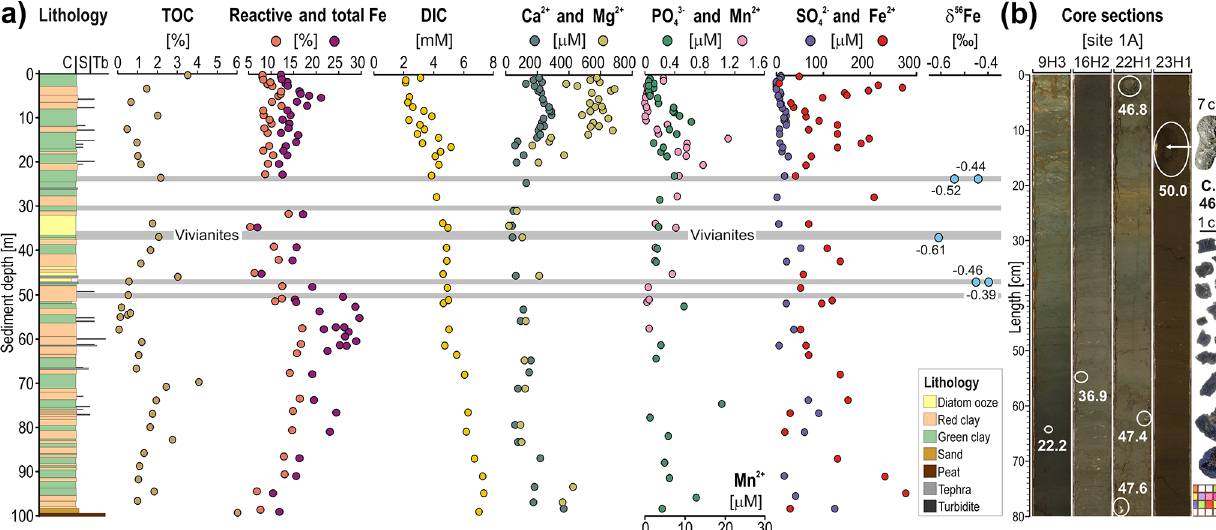
Figure 2. Stratigraphy of composite site TDP-1A: multiple profiles established on sediment core subsamples and core section images. (a) Stratigraphy of composite site TDP-1 (following Russell et al., 2016) and corresponding grain sizes (C: clay; S: silt; Tb: turbidite); total organic carbon (TOC) and reactive and total iron (weight%) in bulk sediment; dissolved inorganic carbon (DIC) (mM), calcium, magnesium, phosphate, manganese, sulfate, and ferrous iron concentrations (µM) measured in pore water; and δ 56 Fe isotopic compositions of vivianite crystals. (b) Images of core sections from which vivianite crystals were handpicked. Crystals on the far right were extracted from core